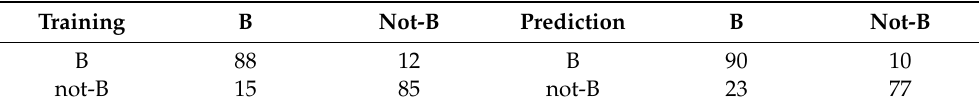
Table 1. Confusion matrix (i.e., percentages of correct assignations as well as misclassifications) for the GA-LDA classification model. True classes are reported in columns, assigned classes are reported in rows.